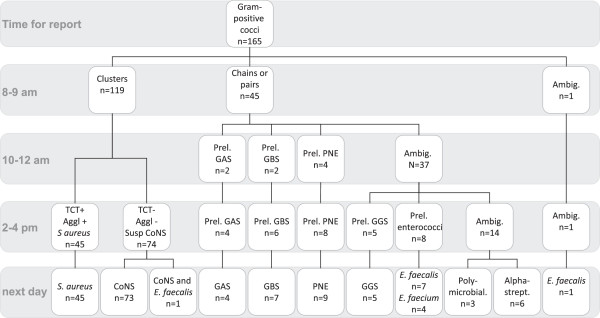
Species identification and reports given based on rapid testing on consecutive patient samples. The flowchart approach in Figures 
1 and
2 was used to analyse gram-positive samples from patients in Kalmar from March 1st 2009 to January 31st 2010. The chart shows the information given to clinicians at different times. (Prel.: Preliminary, TCT: tube coagulase test, aggl: agglutination, PNE:pneumococci, GAS/GBS/GCS/GFS/GGS: group A/B/C/F/G streptococci, ENT: enterococci, CoNS: coagulase-negative staphylococci, ambig: ambiguous).